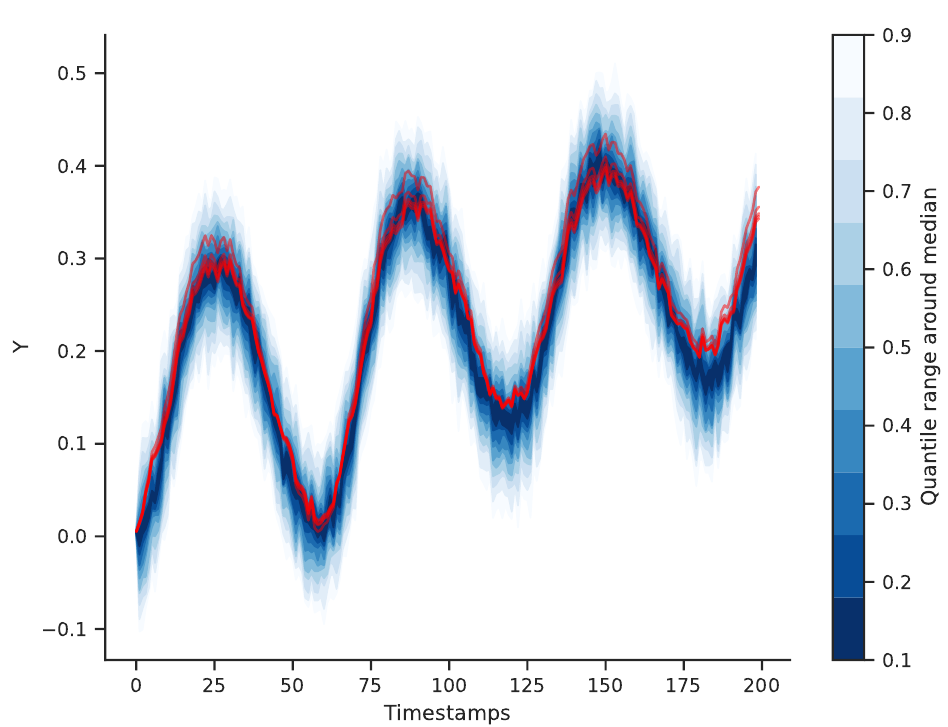
Figure 6. Out-of-sample simulation of five system realizations and the inferred Stan model (cluster c 0